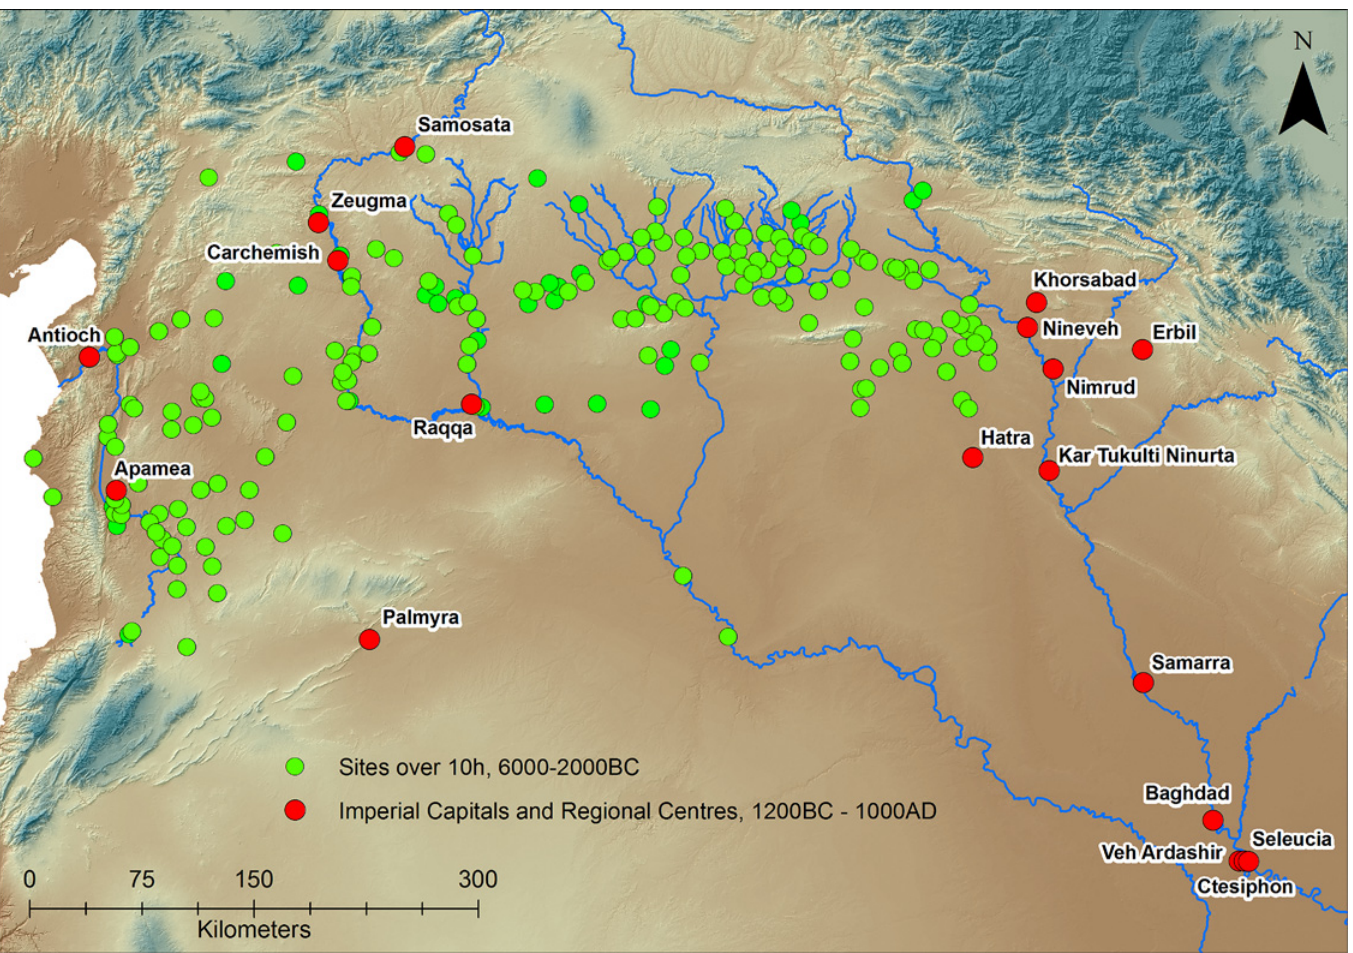
Fig 3. Urban Settlements used in this paper. The green circles represent all sites over 10 hectares from 6000 – 1200 BC, red represents the dataset of urban sites over 100 ha dating between 1200 BC and 1000 AD. Background SRTM DEM courtesy of the U.S. Geological